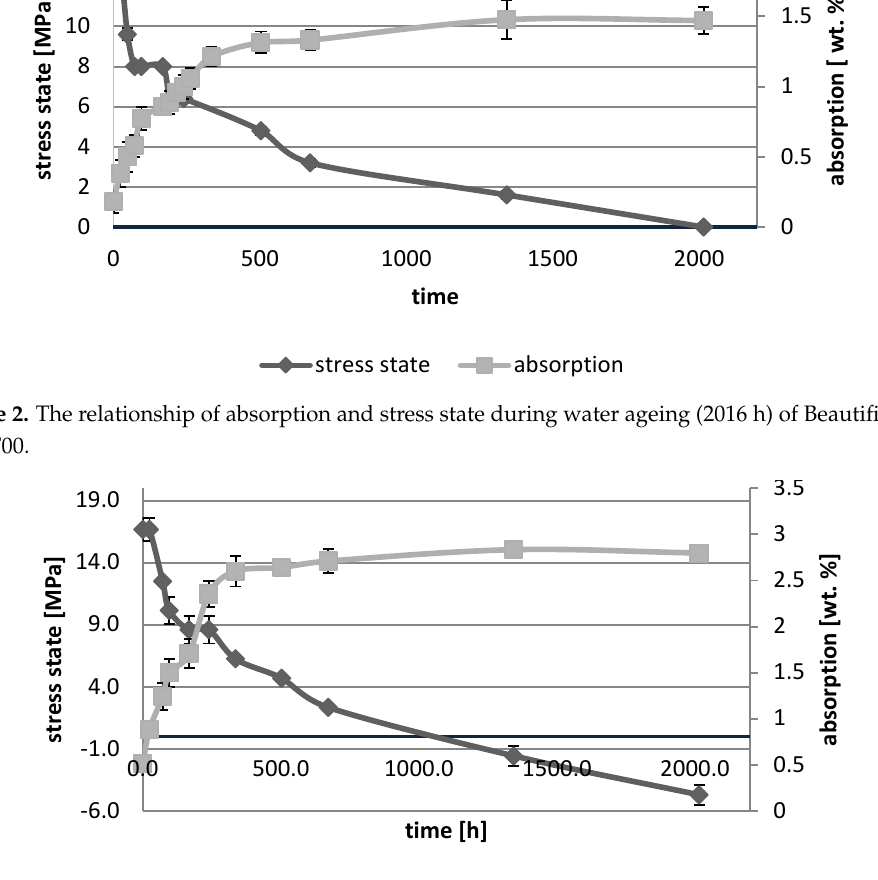
Figure 3. The relationship of absorption and stress state during water ageing (2016 h) of Beautifil Flow F02.